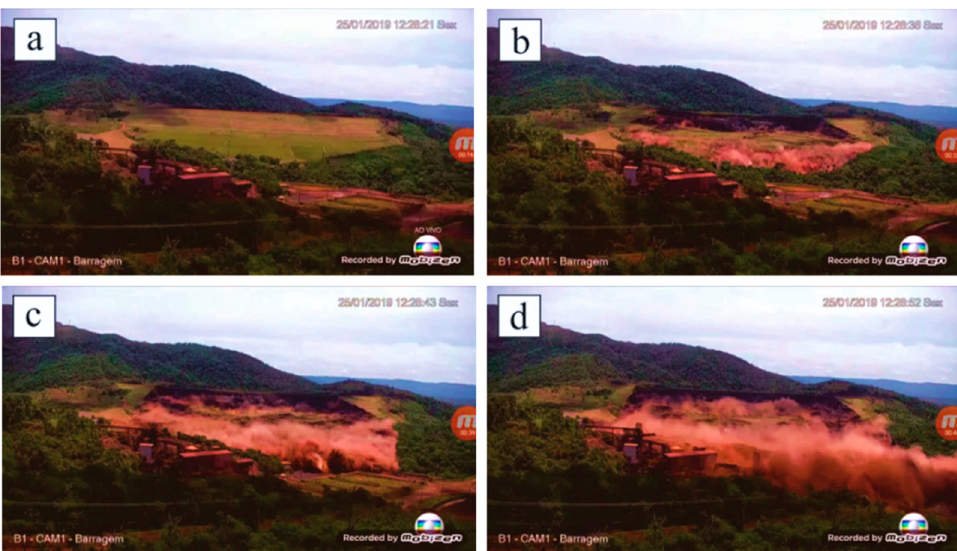
Figure 2. Video screenshots of the Brumadinho tailings dam failure [14]; (a) 25 January 2019, 12:28:21; (b) 25 January 2019, 12:28:36; (c) 25 January 2019, 12:28:43; (d) 25 January 2019, 12:28:52 ( b ) 25 January 2019, 12:28:36; ( c ) 25 January 2019, 12:28:43; ( d ) 25 January 2019, 12:28:52 (local (local time).